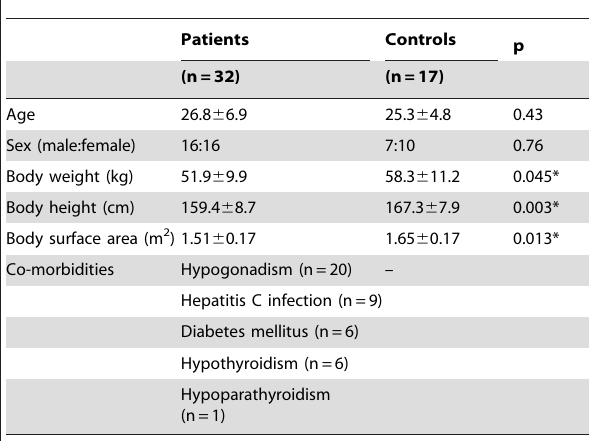
Table 1. Characteristics of